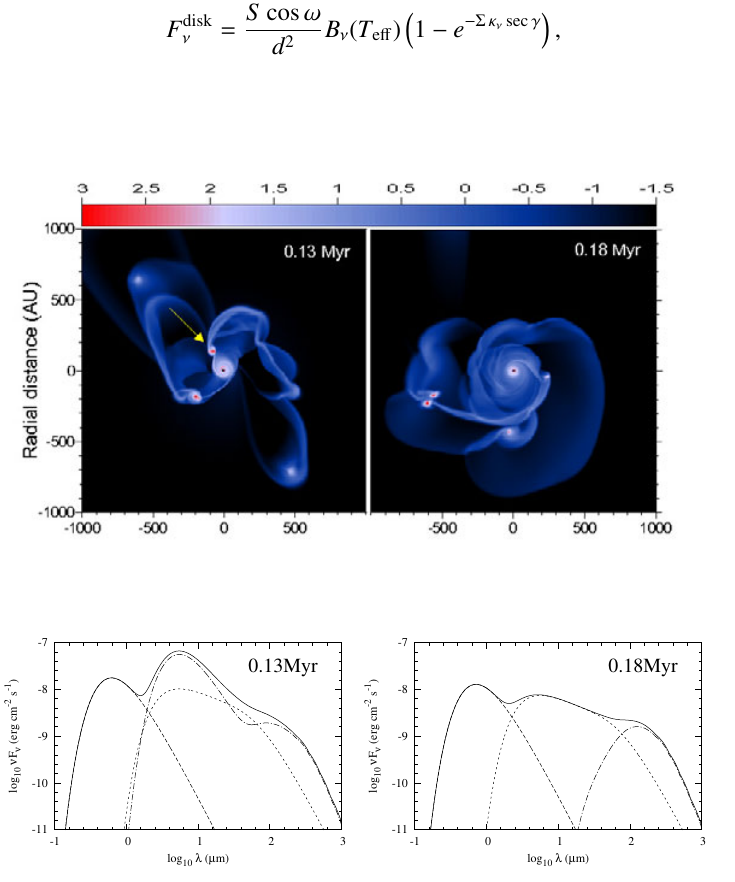
Figure 1. Top panels. Gas surface density maps of a fragmenting protostellar disk. The most massive fragment is shown by the arrow. Bottom panels . The corresponding SEDs. The total flux is shown by the solid